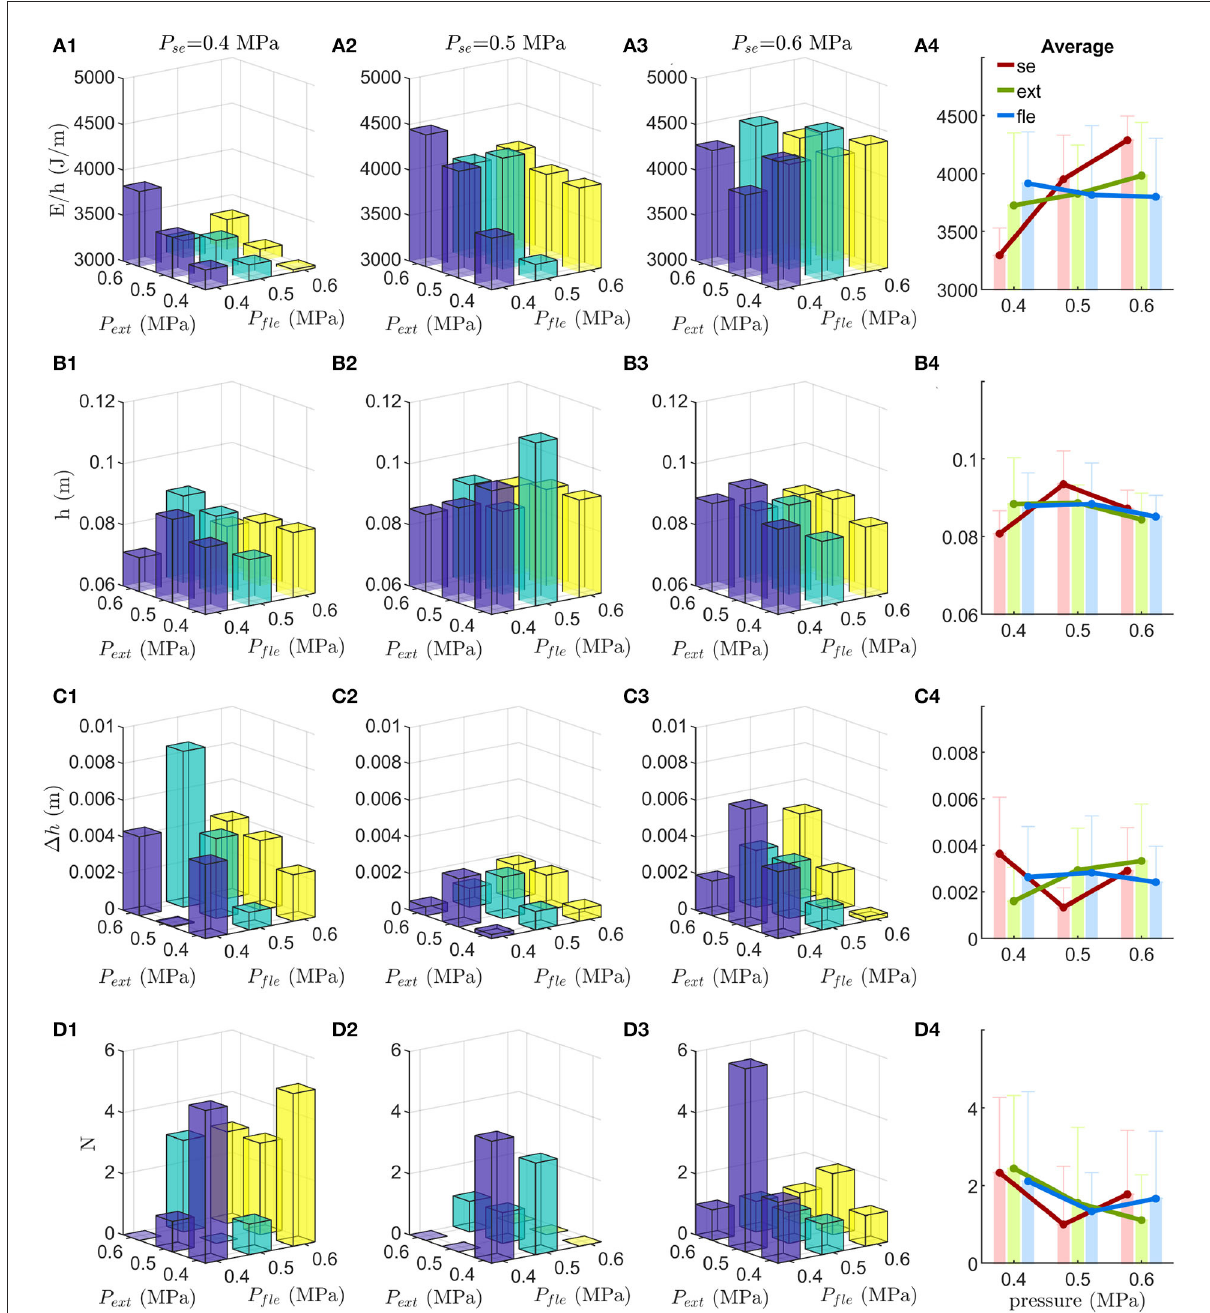
FIGURE2 Experiment results on EPA-Hopper. The four hopping metrics vs. different PAM pressure ( P ). The subscripts se , fle , and ext indicate the serial, flexor, and extensor PAMs, respectively. (A) Normalized energy consumption ( E / h ). (B) EPA-Hopper stable hopping height ( h ). (C) Stable hopping height difference ( 1 h ) as a measure of stability. (D) Hopping robustness in terms of the number of hops ( N ) required to recover from the perturbation. The figures in the 4th column show the average and standard deviation of E / h , h , 1 h , and N with respect to different pressures in serial, flexor, and extensor